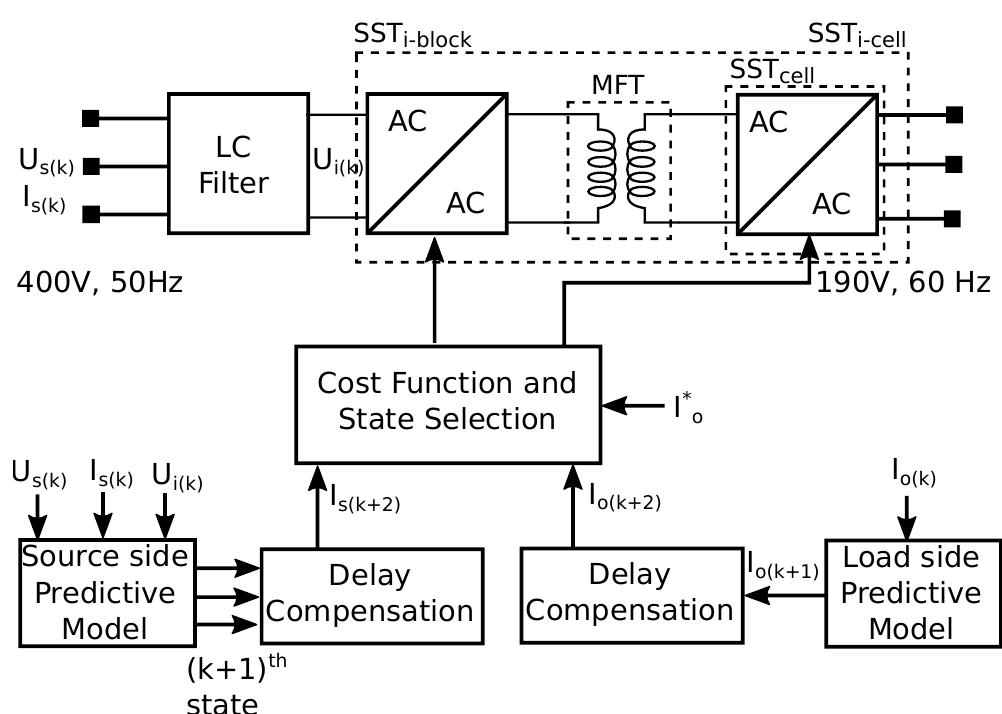
Figure 27. Grid interfacing with MPC as presented in